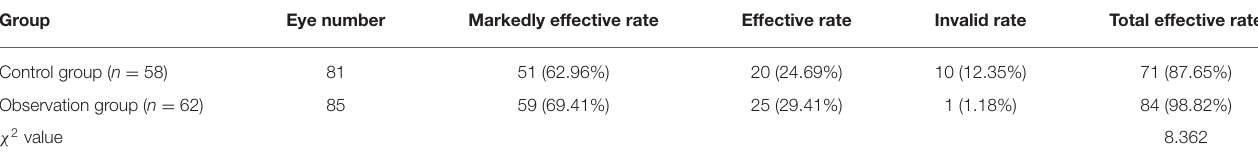
TABLE 1 | Clinical effect of two groups ( n , %).